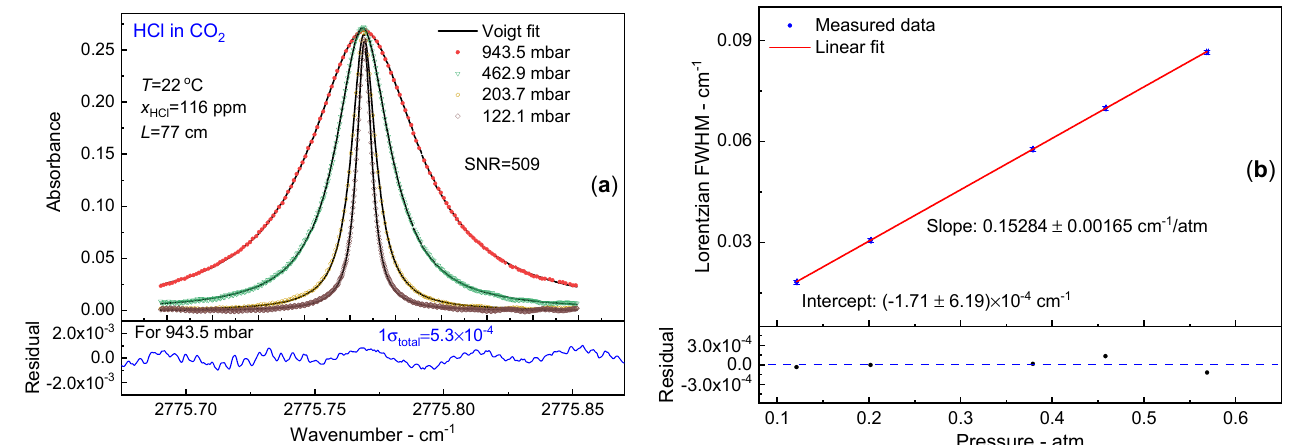
Figure 2. ( a ) Measured CO 2 -broadened HCl absorption spectra at different pressures. The fitting residual is depicted for the spectrum at 943.5 mbar; ( b ) Measured CO 2 induced pressure broadening with a linear fitting model. The residual between fit and data is shown below.